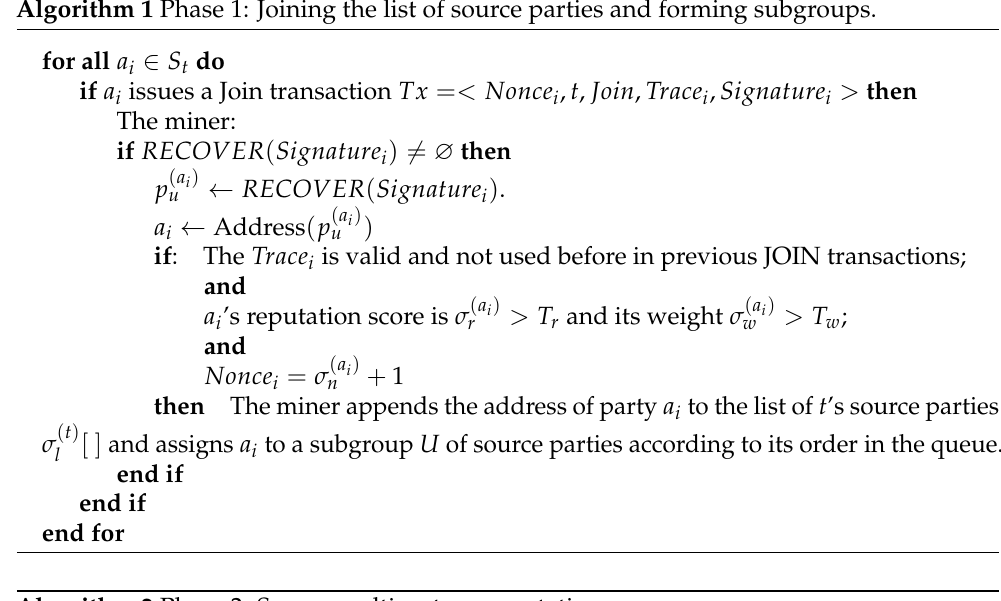
Algorithm 2 Phase 2: Secure multiparty